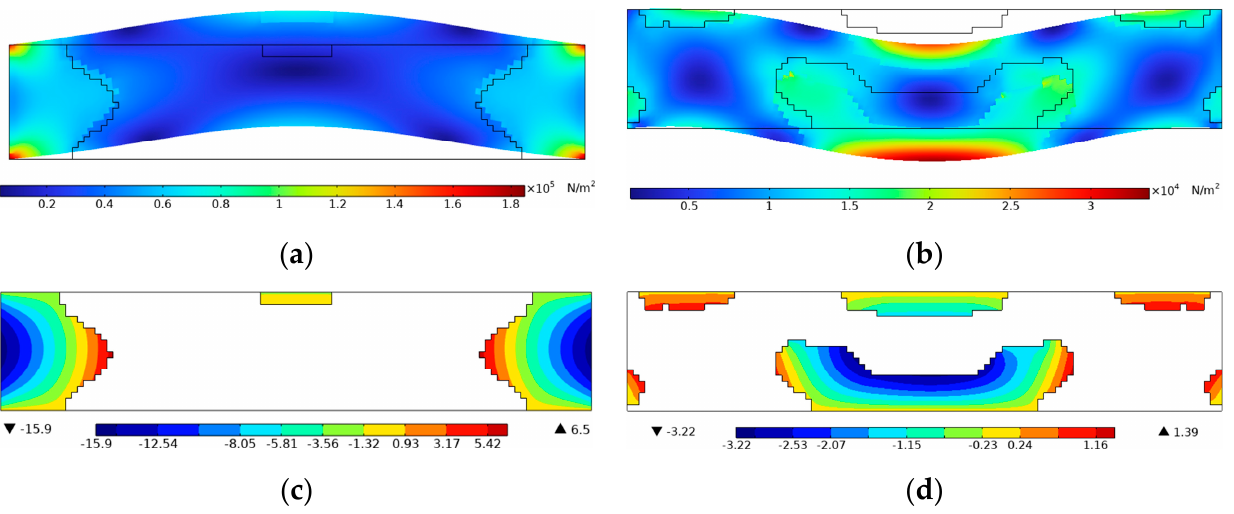
Figure 7. Demonstration of stress mode shape and voltage of Figure 4a,d. ( a ) Von Mises stress contour of Figure 4a, f = 4 kHz; ( b ) Von Mises stress contour of Figure 4d, f = 16 kHz; ( c ) Voltage contour of Figure 4a, f = 4 kHz; ( d ) Voltage contour of Figure 4d, f = 16 kHz.